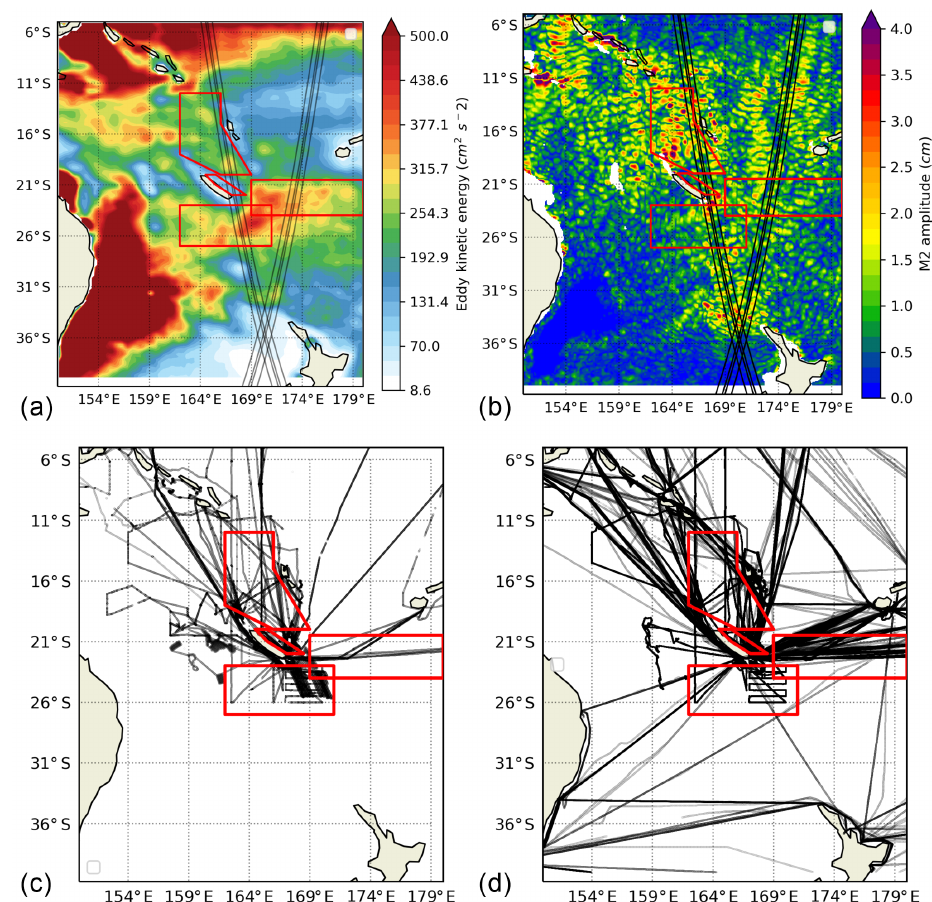
Figure 2. Regions of study (red boxes) around New Caledonia: eddy kinetic energy estimated using Duacs (a) , M2 coherent internal tide estimated from satellite altimetry (b) , SADCP (c ) and TSG (d) sections performed in the southwest